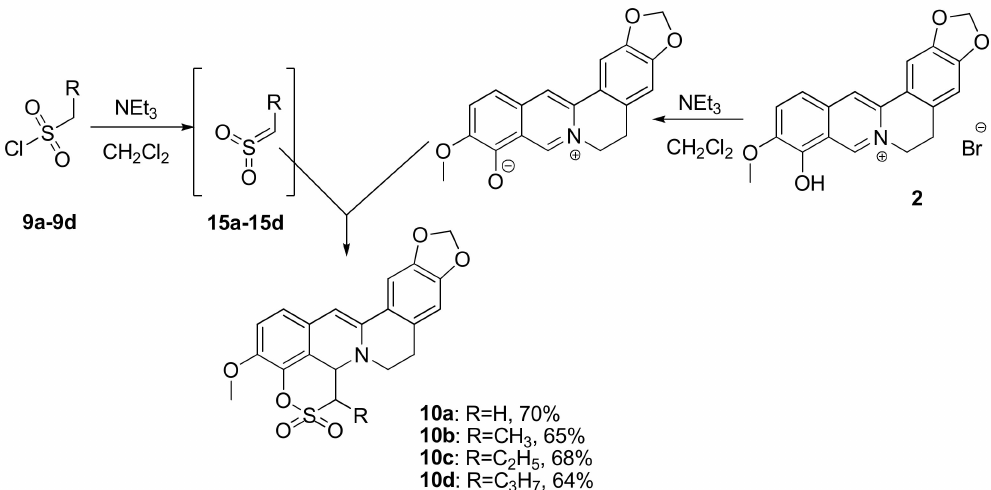
Scheme 8. Design of the experiment leading to selective formation of sultone 10a – d from berberrubine 2 and alkyl- sulphochlorides 9a – d .